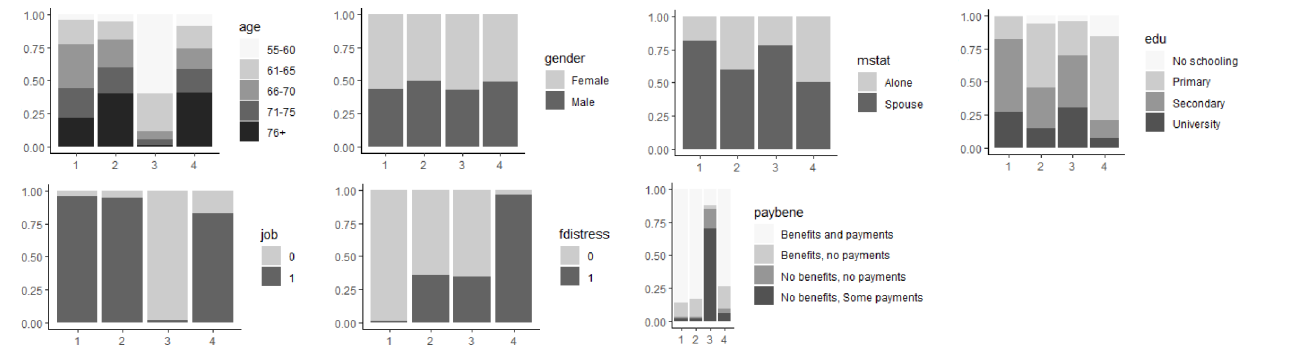
Figure 4. A boxplot distribution of the indices by profile.